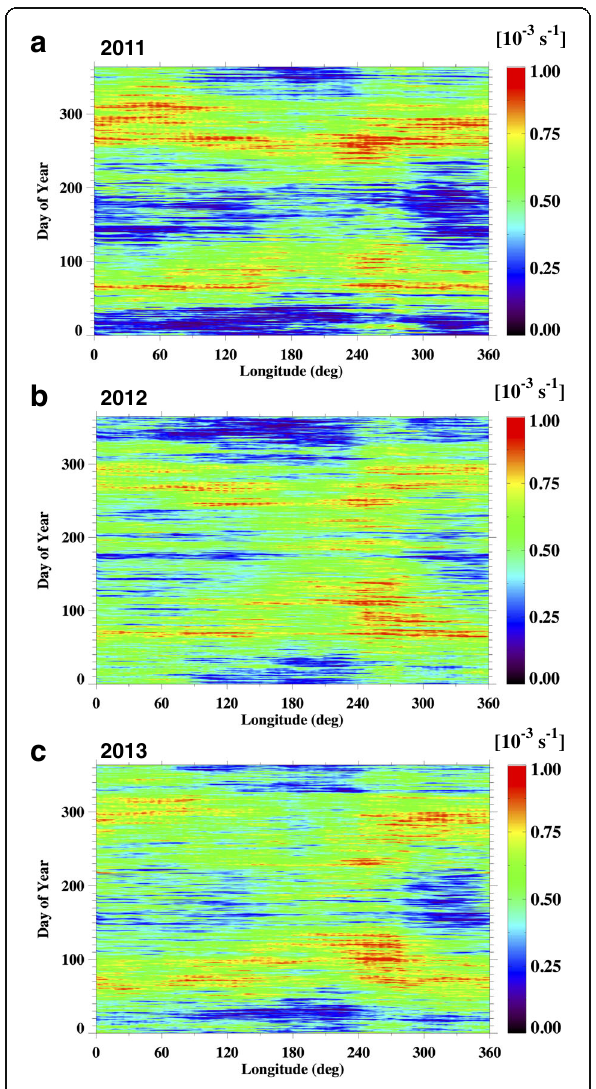
Fig. 1 Seasonal and longitudinal variations in R-T growth rate obtained with GAIA. Seasonal and longitudinal variations of the daily maximum value of the Rayleigh-Taylor instability growth rate at the equator are shown for the years a 2011, b 2012, and c